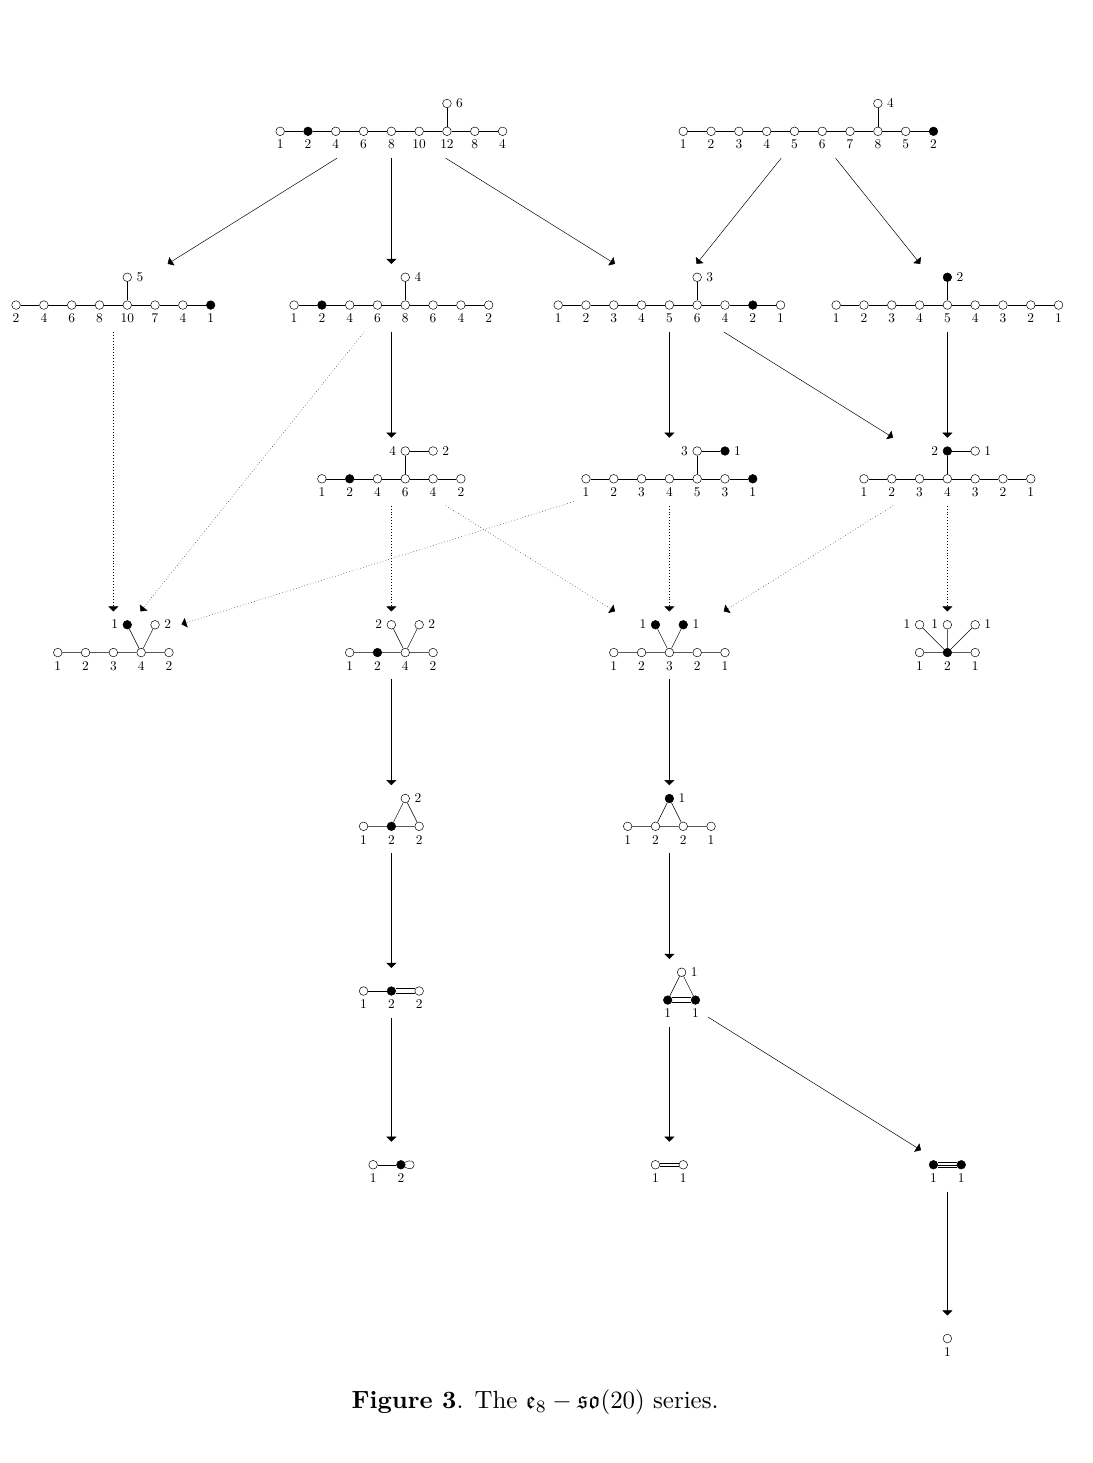
Figure 3 . The e 8